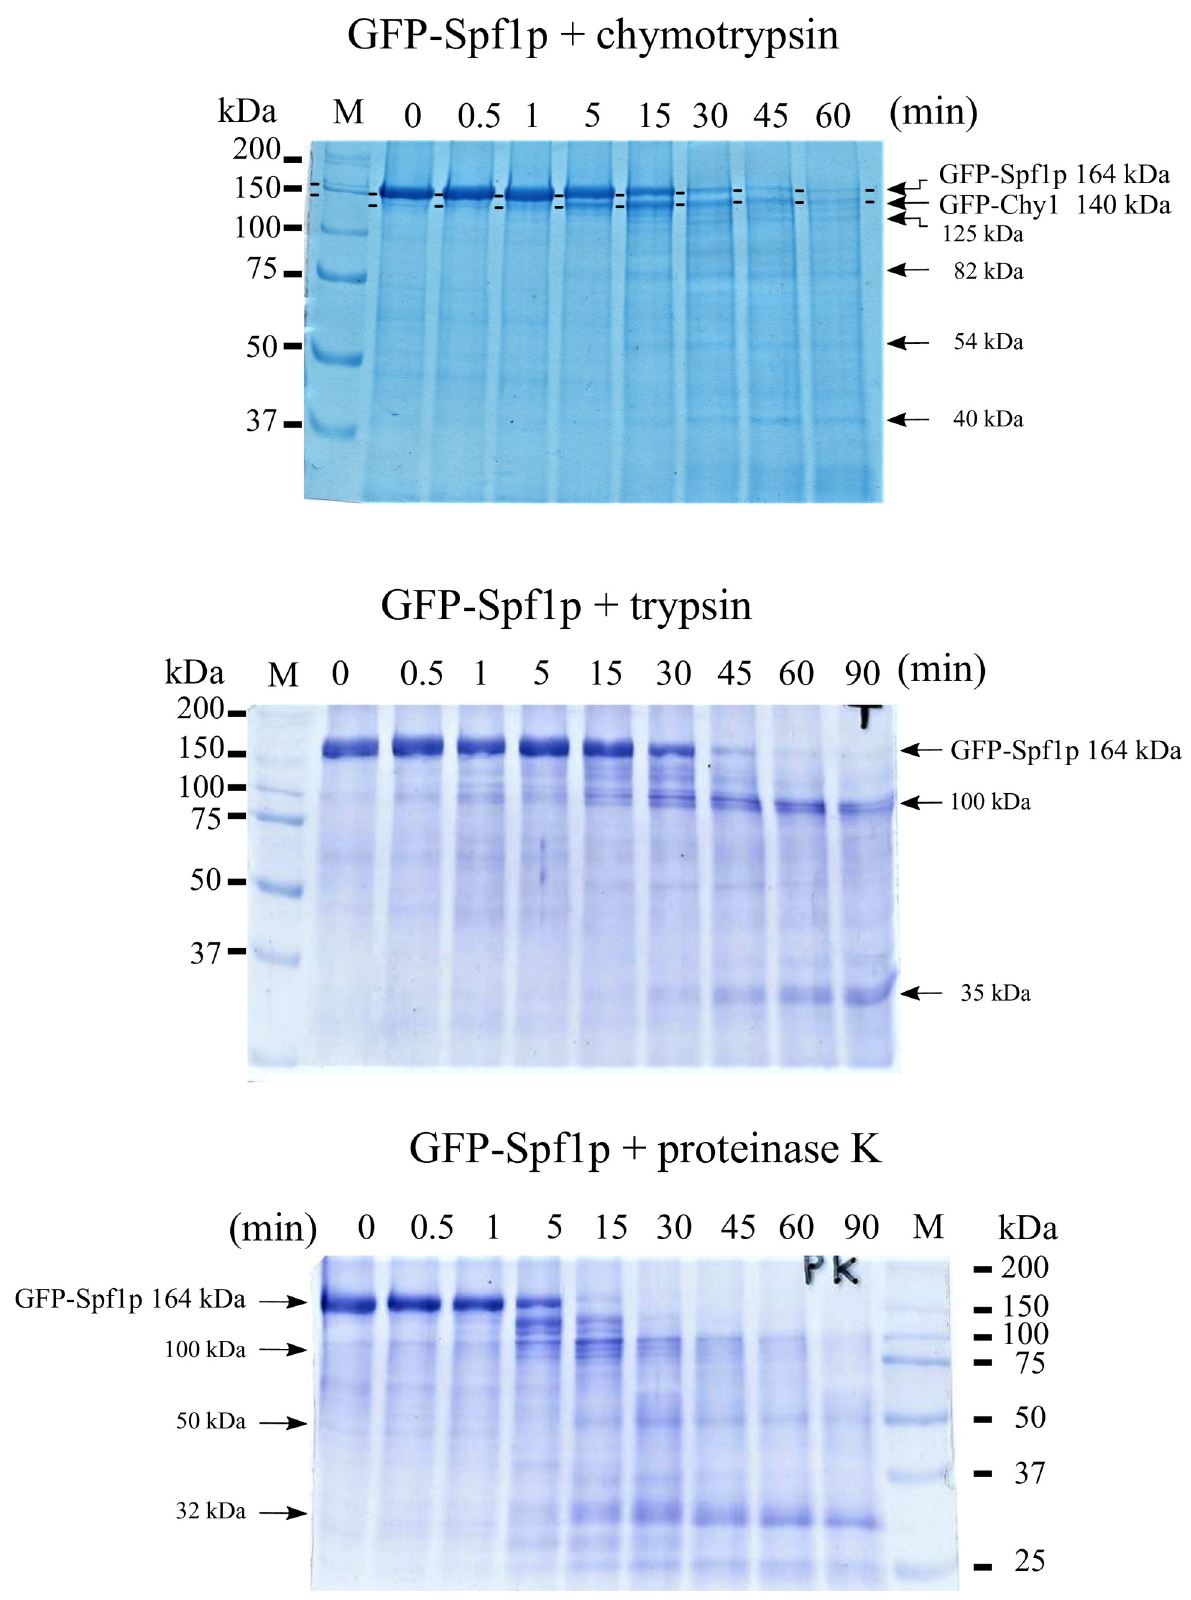
Fig 1. Limited proteolysis of GFP-Spf1p. 2.5 μ g of GFP-Spf1p was treated with the indicated protease as described under “Materials and methods”. After the time indicated on top of each lane the proteolysis was stopped by the addition of TCA and the samples submitted to